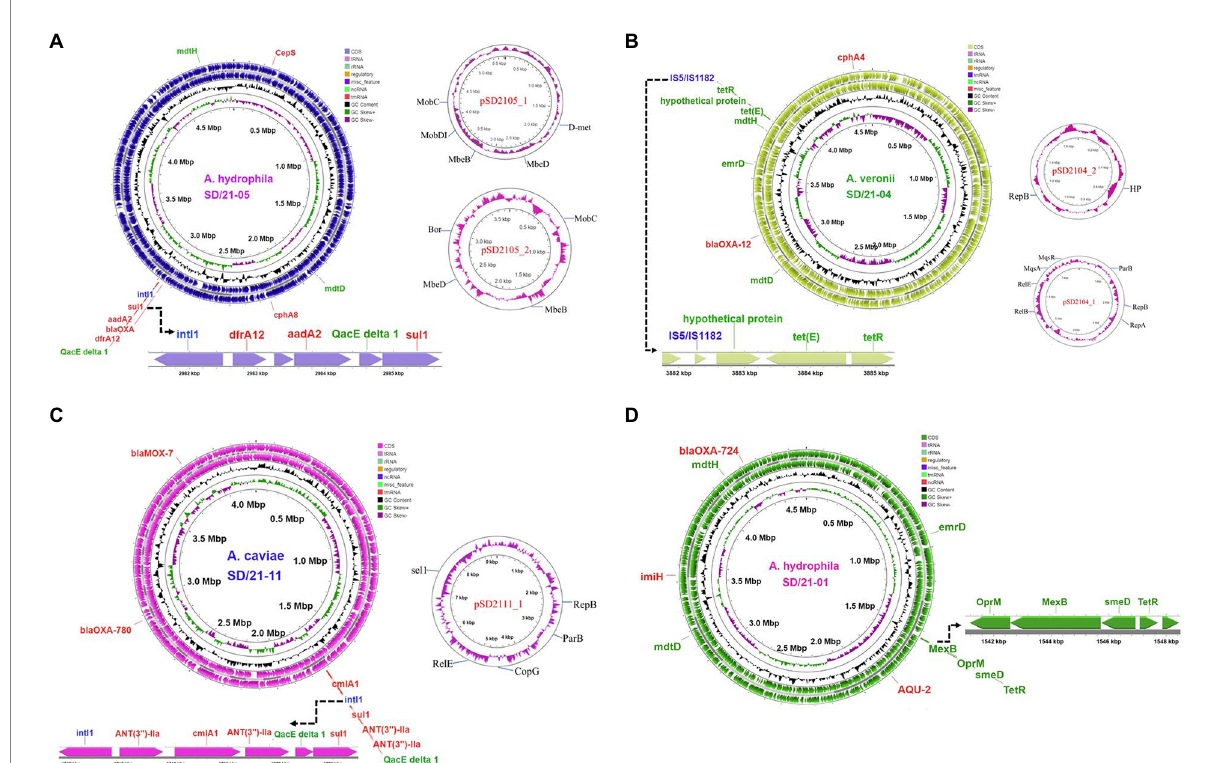
FIGURE 6 Circular maps of whole genome sequences of Aeromonas spp. isolated from four fish species in India. (A) Circular map of whole genome sequence of Aeromonas hydrophila strain SD21/21–05 (blue) isolated from Indian carp ( Labeo rohita ) showing the loci for the resistance genes (red), efflux pumps (green) and integrase (blue). The extended linear map shows the integrase intl1 linked to dfrA12 , aadA2 , QacEdelta 1 and sul1 . Circular maps of the two plasmids detected are shown in pink. (B) Circular map of whole genome of A. veronii strain SD/21–04 isolated from Clarias batrachus showing the loci for resistance genes (red), efflux pumps (green), and transposases (blue). The linear map shows the transposases linked to the hypothetical protein, tet(E) efflux pump and TetR is the repressor of the tetracycline resistance element. Circular maps of the two plasmids are shown in pink. (C) Circular map of the A. caviae strain SD/21–11 isolated from Oreochromis niloticus showing positions of the resistance genes (red), integrase (blue) and efflux pumps (green) with the linear map showing the integrase intl1 linked to the ANT(3 ″ )-IIa , cmlA1 , ANT(3 ″ )-IIa , QacEdelta 1 and sul1 genes. Circular map of the single plasmid is shown in red. (D) Circular map of A. hydrophila strain SD/21– 01 isolated from Catla catla showing resistance genes (red) and efflux pump proteins (green). The extended linear map shows the multidrug complex OprM-MexB and RND pumps linked to the tetR